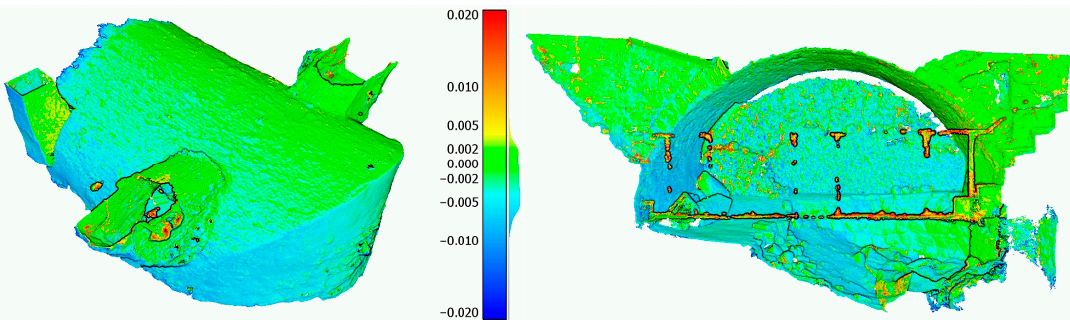
Figure 16. Deviations in the comparison of photogrammetry with all images active and the variant without connection through openings 2 and 3 (A vs. B) in the ossuary (external view on the left , cross-section on the right ).